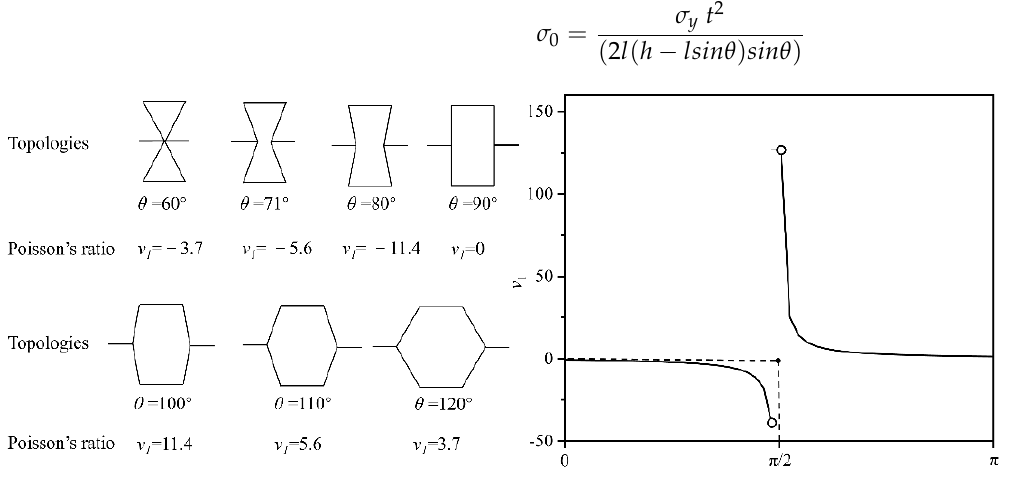
Figure 5. Relationship between topology and Poisson ’ s ratio.